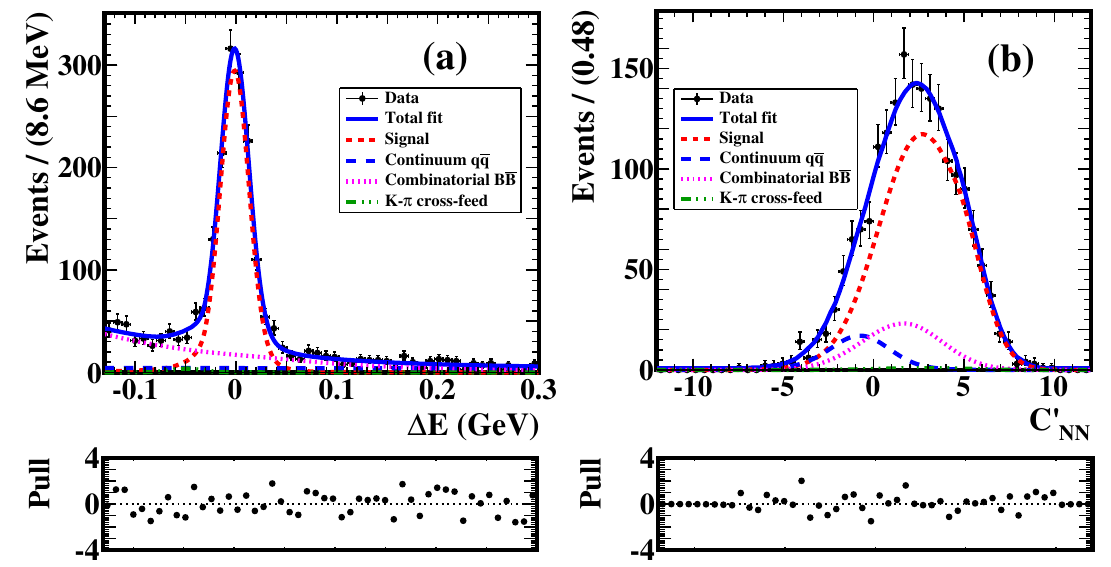
Figure 4 . Signal-enhanced (cid:12)t projections of (a) (cid:1) E and (b) C 0 for the B (cid:6) ! D(cid:25) (cid:6) data sample NN in bin 1. The black points with error bars are the data and the solid blue curves are the total (cid:12)t. The dotted red, blue, magenta, and green curves represent the signal, continuum, combinatorial BB backgrounds and cross-feed peaking background components, respectively. The pull between the data and the (cid:12)t is shown for both the